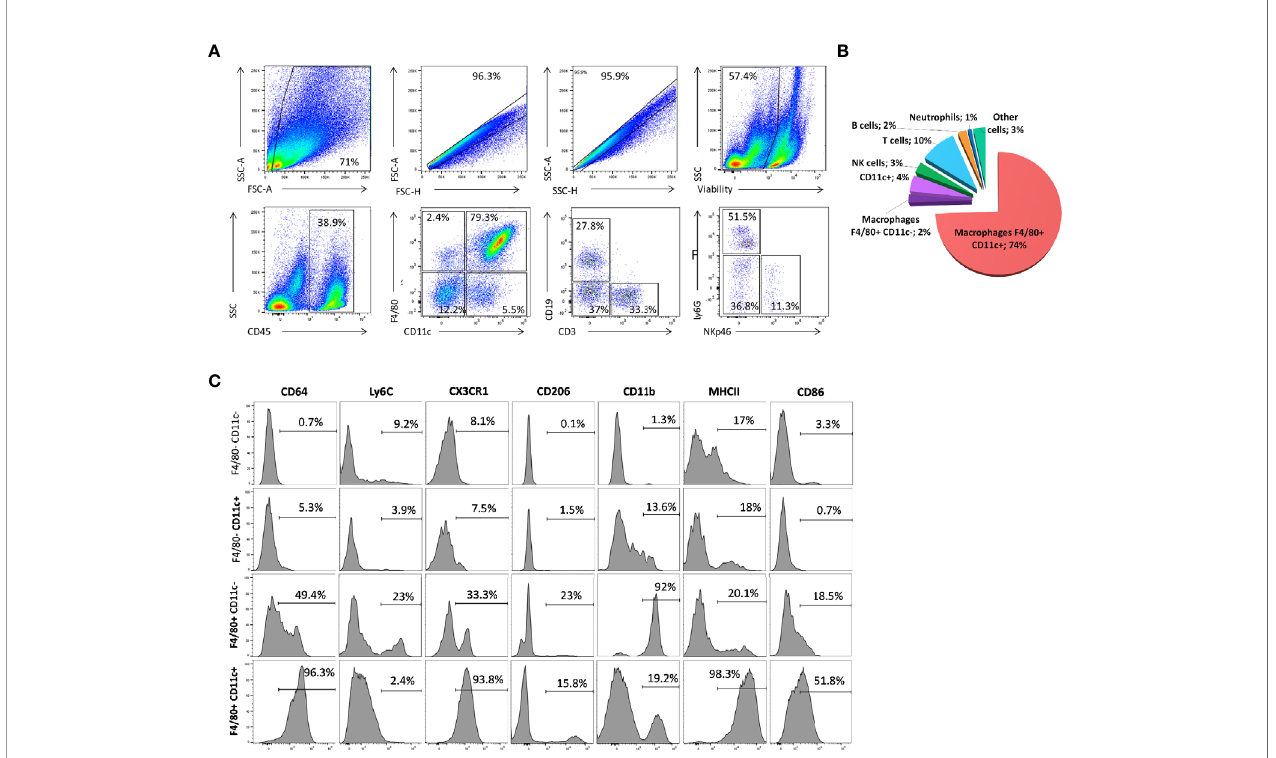
FIGURE 3 | Immune-cell composition of the lactating mammary gland. (A, C) Flow cytometry analysis of the immune landscape on single-cell suspension from lactating mammary tissue. The numbers indicate the percentage of cells within the corresponding gate. These patterns are representative of one of 10 individual mice analyzed, each giving similar results. (B) Pie chart showing the proportions of CD45 pos immune cells in the lactating mammary gland by fl ow cytometry. The numbers indicate the percentage of each cell type among all living CD45 pos immune cells. (C) Flow cytometry analysis of the level of various markers in F4/80 CD11c double- negative, single-positive, and double-positive CD45 pos cell